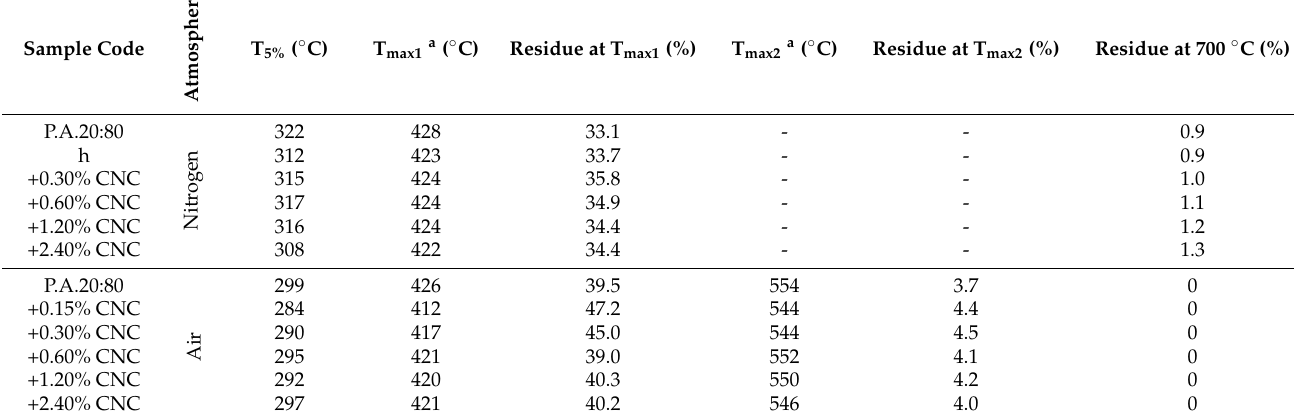
Table 7. Thermogravimetric data for CNC-based